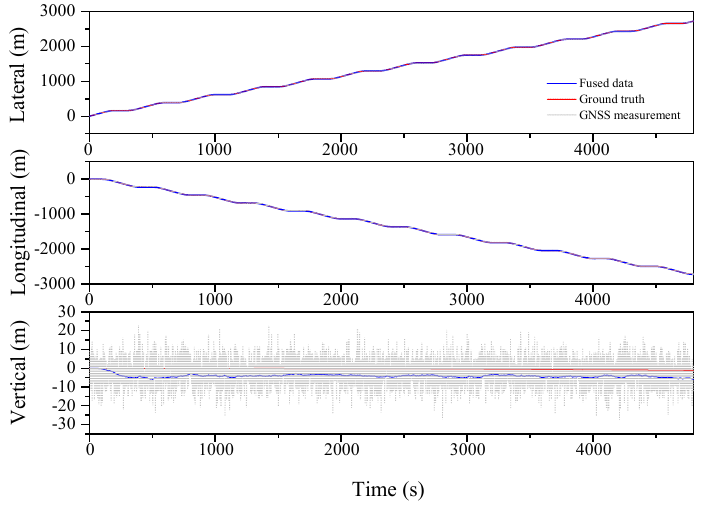
Figure 7. Lateral, Longitudinal and Vertical positions of EKF (Serpentine 1).